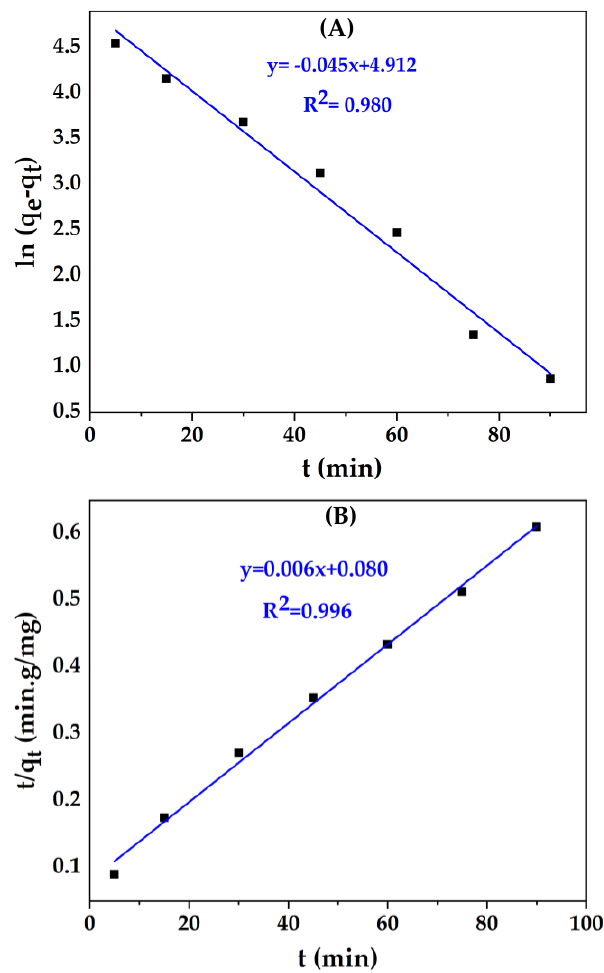
Figure 5. Pseudo-first-order ( A ) and pseudo-second-order ( B ) linear data fit for MB removal BGS- derived